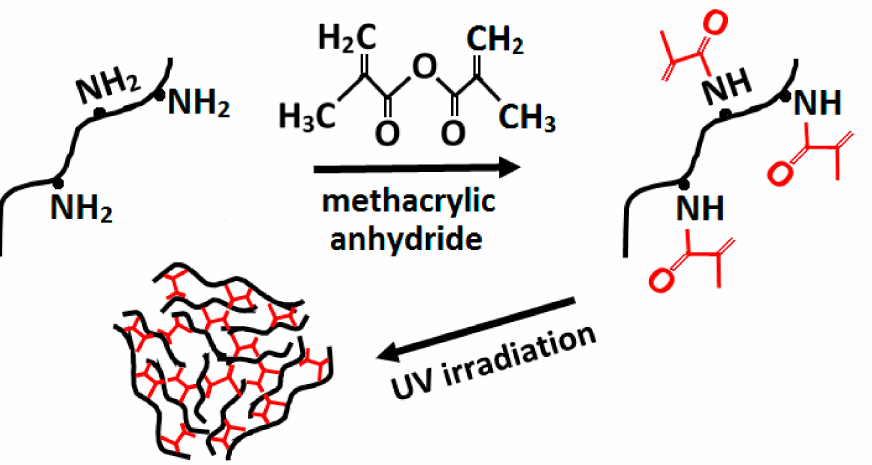
Figure 8. Modification of amino groups in gelatine/collagen with methacrylic anhydride. Crosslinking of collagen chains affects the material mechanical parameters, which depend on the degree of crosslinking and the absence of crystallinity [169]. The swelling of collagen under physiological conditions makes it an ideal material for use as bioink [170]. After physically or chemically crosslinking, an insoluble 3D structure is created,